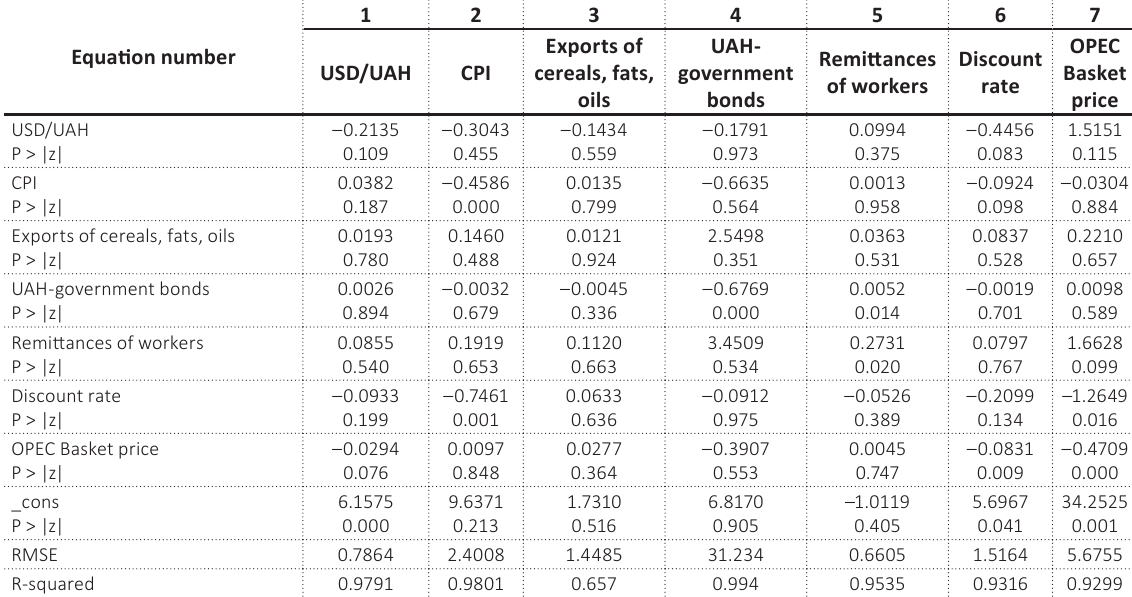
Table C2. VAR (2) model results (standard OLS regression summary statistics)